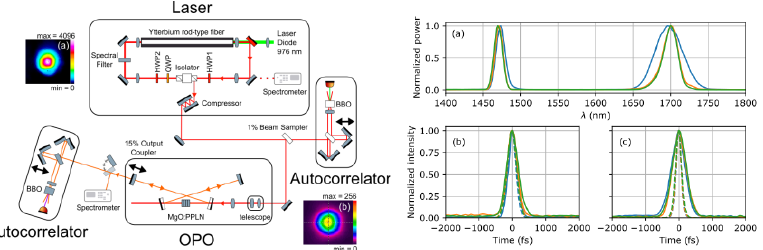
Fig. 1. (Left) Set-up of the femtosecond large-mode-area fiber laser and the linear optical parametric oscillator. QWP, quarter-wave plate; HWP, half-wave plate; MgO:PPLN, Magnesium doped periodically polarized lithium niobate. a-b) spatial profile of the beam delivered by the laser and OPO, respectively. (Right) Spectra and autocorrelation traces of the signal pulse delivered by the OPO. The curves are in green for the fundamental, in orange for the 2f 0 and in blue for the 3f 0 PRR. (a) 1470nm and 1695nm spectrum. FWHM for 1470nm is 14.0nm, 13.0nm and 13.0nm; FWHM for 1695 nm is 44.0nm, 24.0nm and 22.0nm. (b) Autocorrelation trace for the 1470nm spectrum. Measured durations (plain line) are 290fs, 360fs and 420fs; Fourier-limited durations (dot line) are 277fs, 347fs and 322fs for the